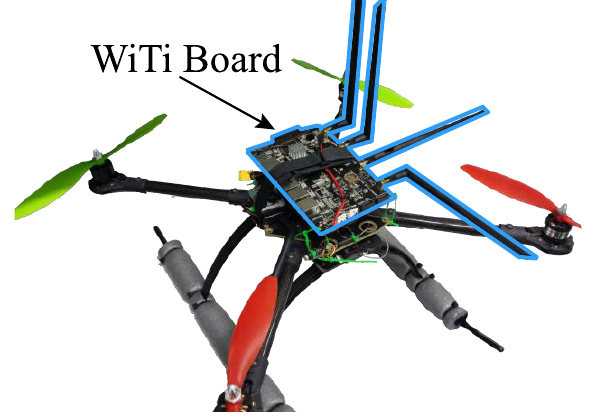
Figure 9. UAV and WiTi device.